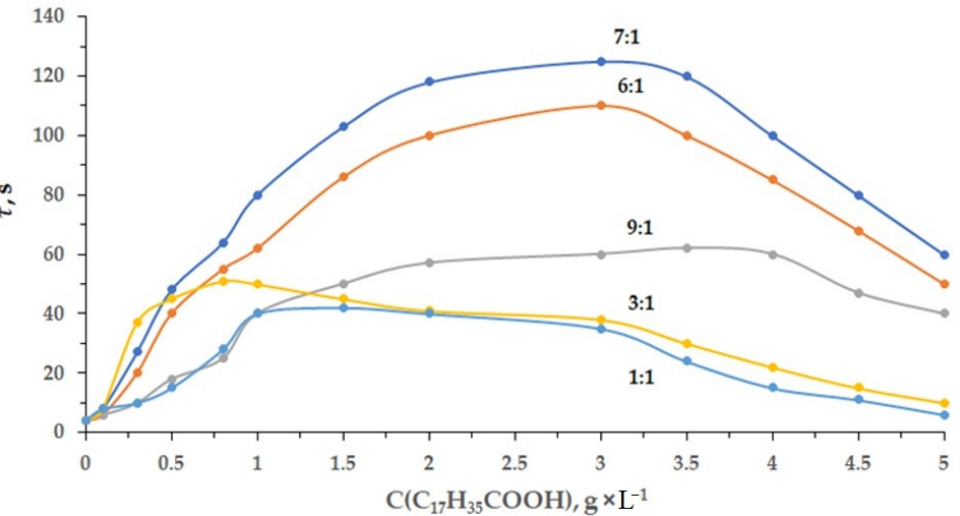
Figure 5. The protective periods of coatings formed at various concentrations of stearic acid in DMSO/H 2 O binary mixtures with various compositions.